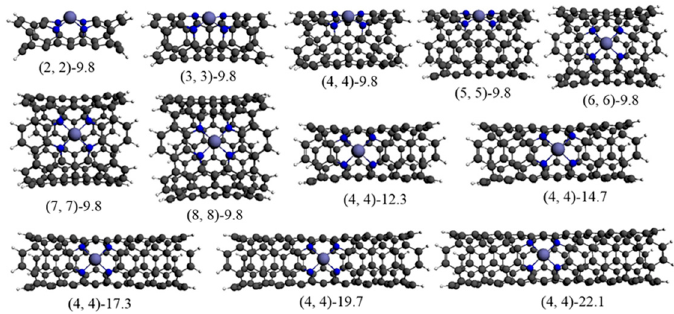
Figure 1. Optimized structures of Fe − N 4 site in CNTs.